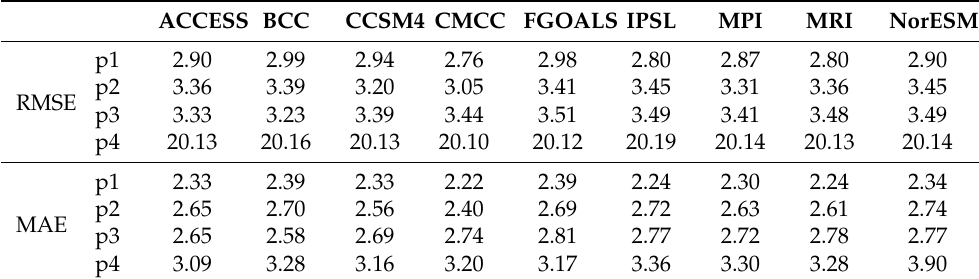
Table 3. RMSE and MAE of our PDSI with PDSI outputs of Dai